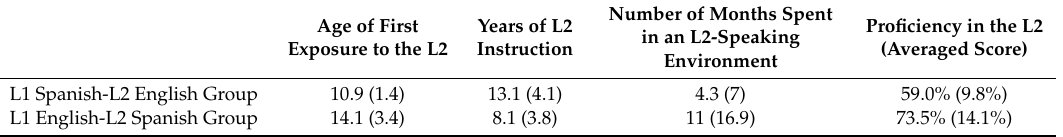
Table 1. Participants’ language background and proficiency